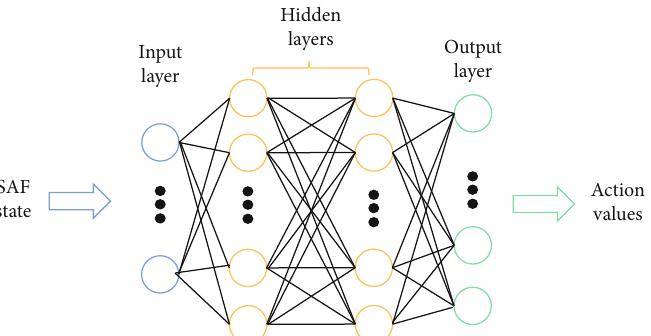
Figure 5: The framework of a Q -network.